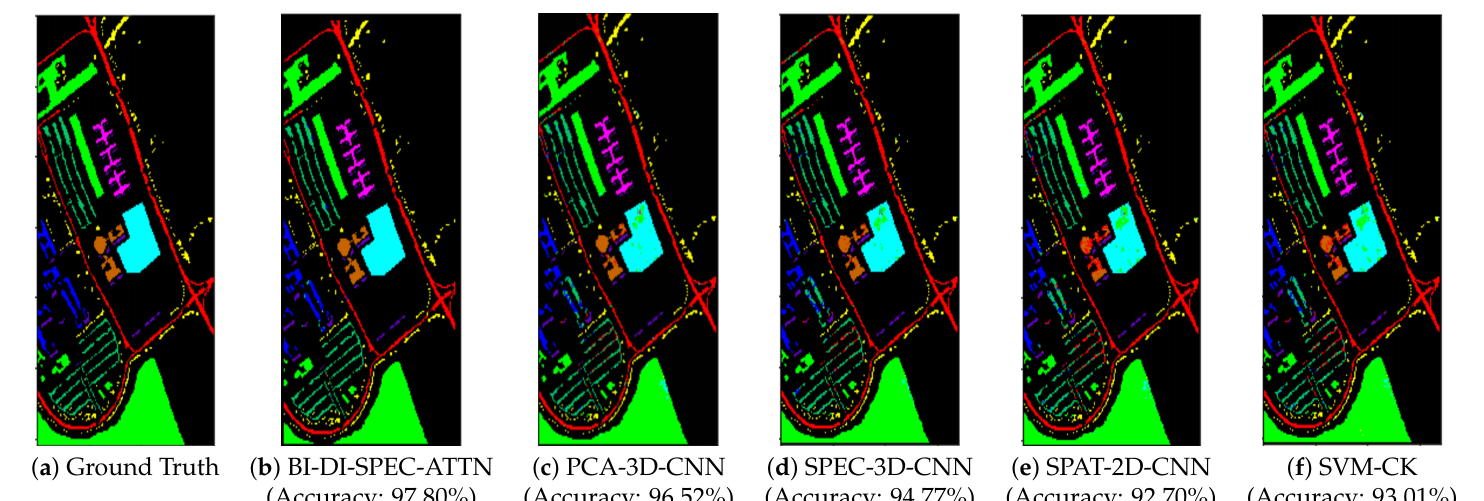
Figure 4. Classification maps of Pavia University dataset for all proposed methodologies using 10% of training